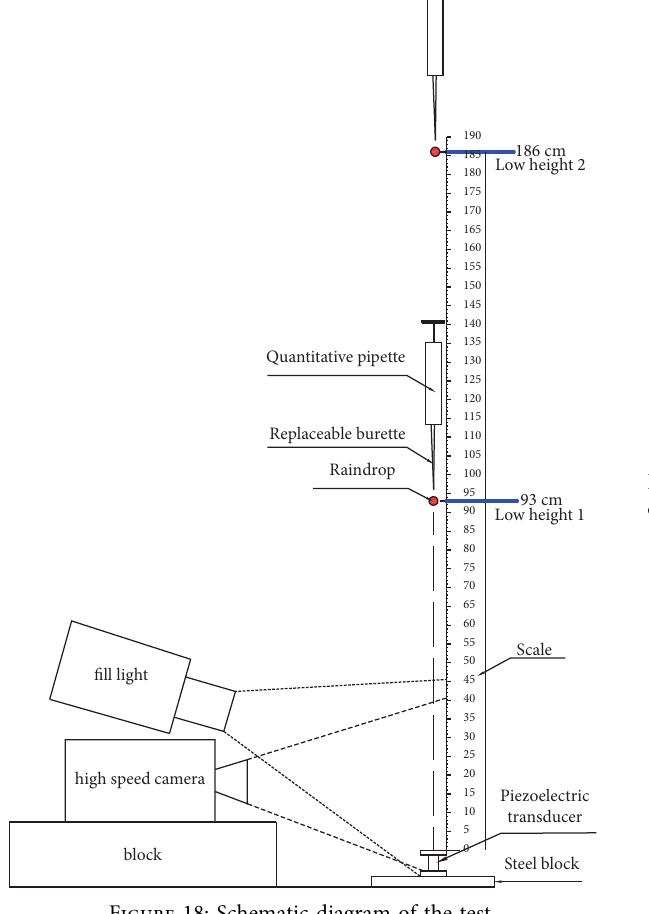
Figure 18: Schematic diagram of the test.